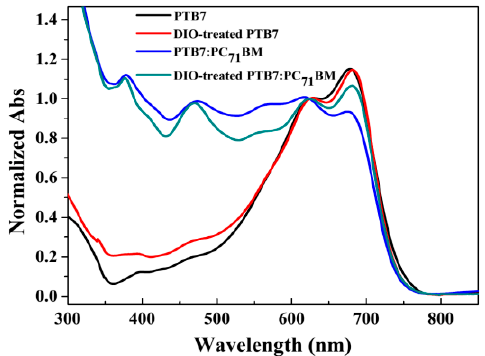
Figure 3. UV-Vis absorption spectra of PTB7-based active layers. All spectra were normalized at 623 nm.